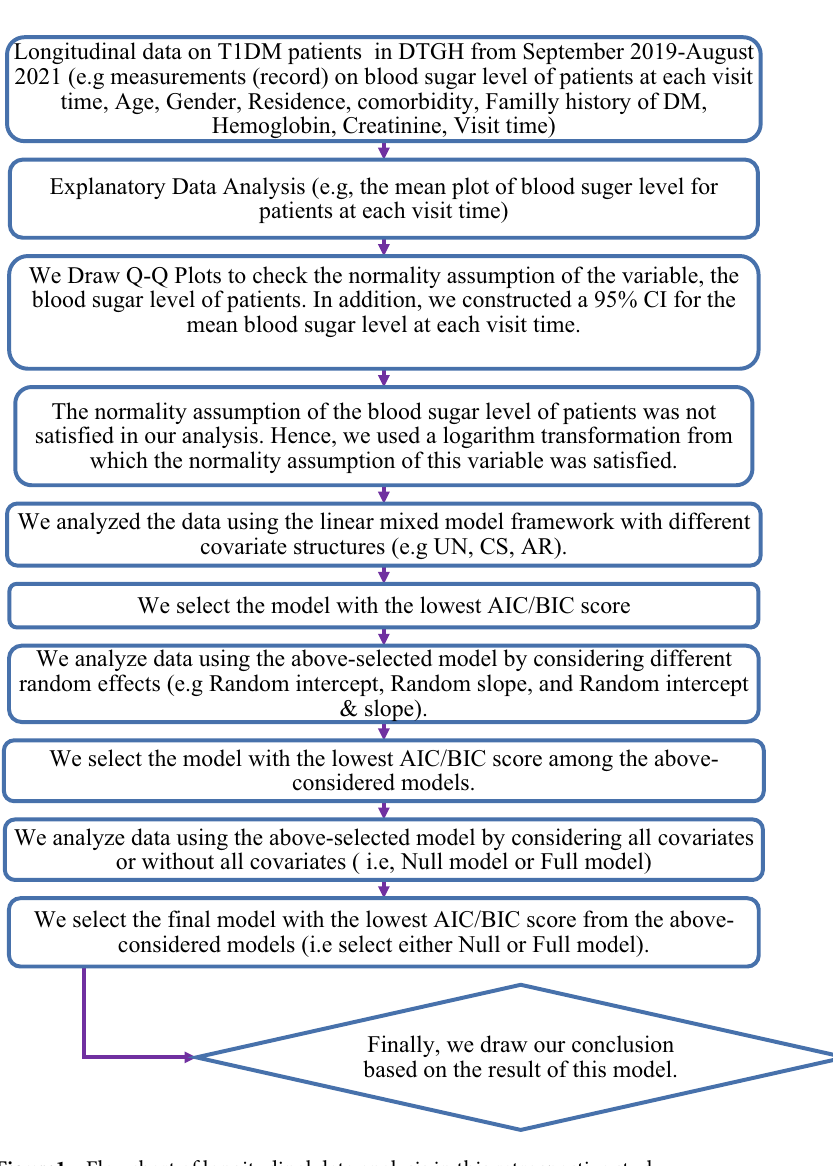
Figure1. Flowchart of longitudinal data analysis in this retrospective